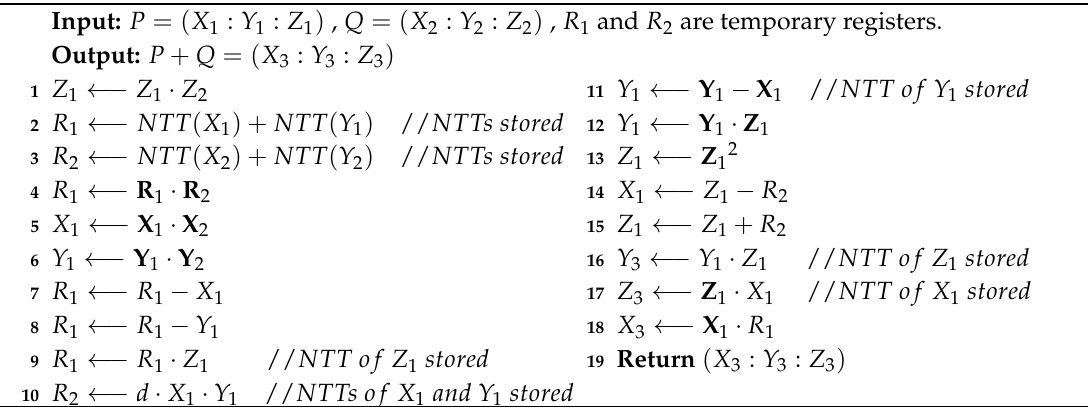
Algorithm 7: Elliptic curve point addition in projective coordinates over prime fields using Edwards curves and NTT-based